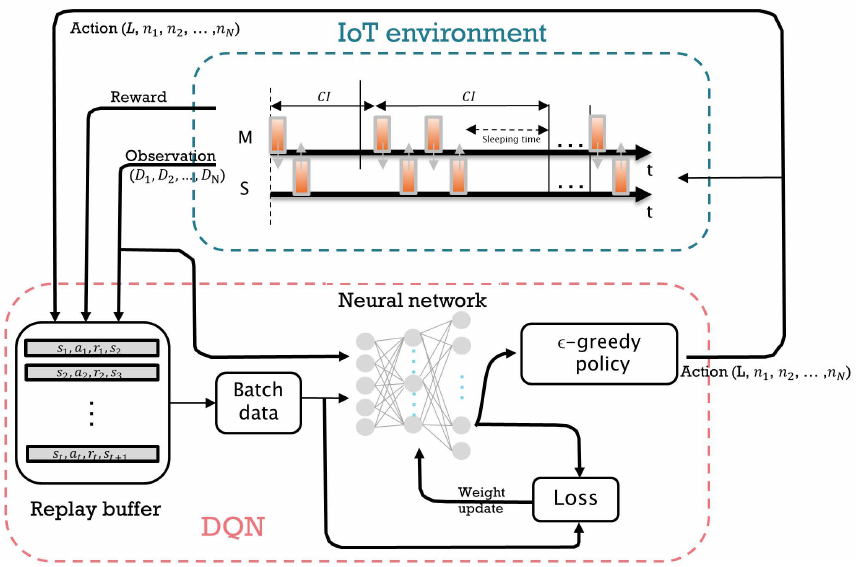
Figure 3. Architecture of the DQN-based scheduling algorithm. At the beginning of the CI, the DQN-based scheduler receives state information (i.e., the remaining lifetime of packets in the queue ( D 1 , D 2 , . . . , D N ) ) from the slaves. Then it performs scheduling actions, i.e., choosing the CI length and the number of packets transmitted by each slave ( L , n 1 , n 2 , . . . , n N ) . The reward r is given to the scheduler as feedback along with the updated state s 2 . Such a sequence of relevant information (i.e., current state s 1 , action a , reward r , and next state s 2 ) is stored in the replay buffer for the training of the DQN-based